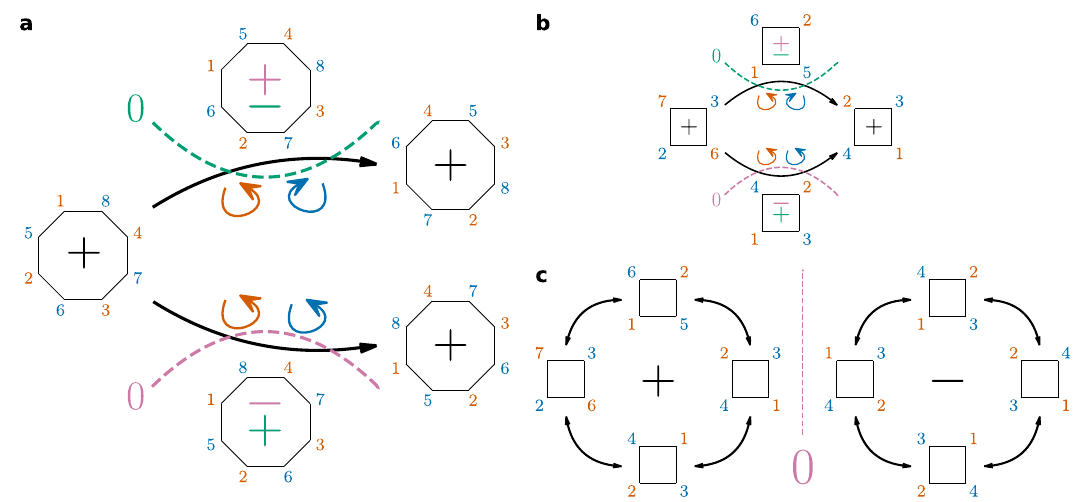
Fig. 4 Antiaromatic systems. Comparison of counter-rotation and co-rotation of the spin-up (orange) and spin-down (blue) electrons for a an eight- electron system and b a four-electron system. The two potential nodes are depicted as dashed lines for both systems: purple (only counter-rotation is possible) and green (only co-rotation is possible). c Assuming a counter-rotation, a node separates two groups of spin-alternating covalent structures with identical individual cyclic orders of the spin rings (shown for the four-electron system).